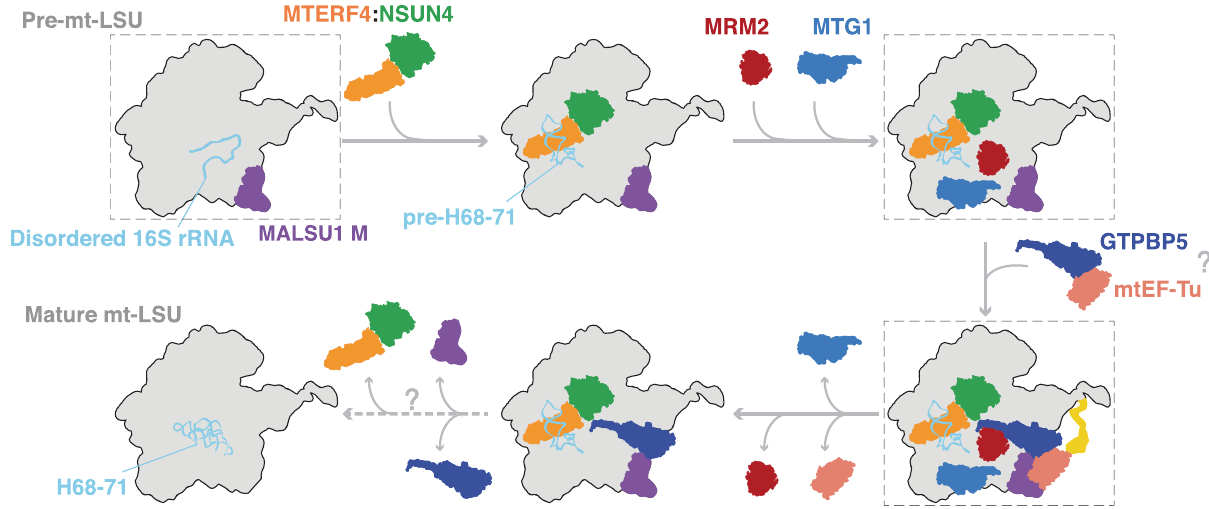
Fig. 5 Model of the fi nal steps of mt-LSU biogenesis. Final steps of mt-LSU assembly. The steps representing resolved structures are highlighted in dashed boxes. The dashed arrow indicates that biogenesis factors are released in an unknown order. Question marks refer to not yet known